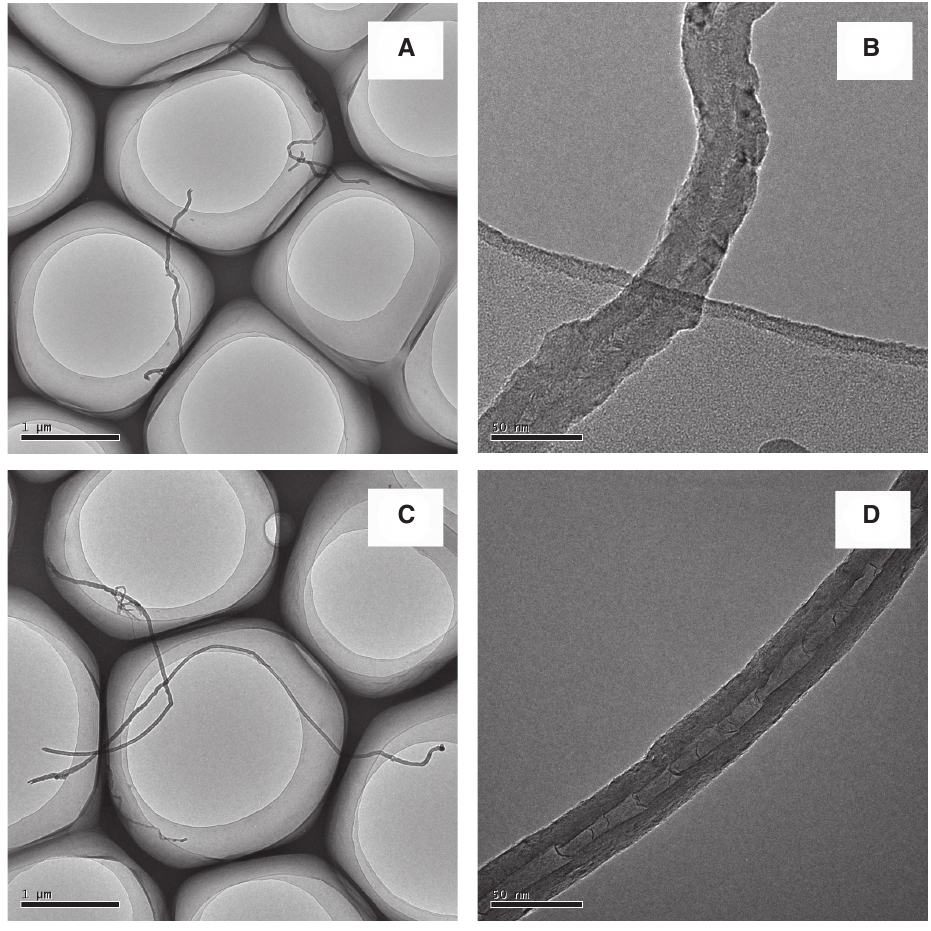
Figure 1 TEM images of CNTs with different aspect ratios.